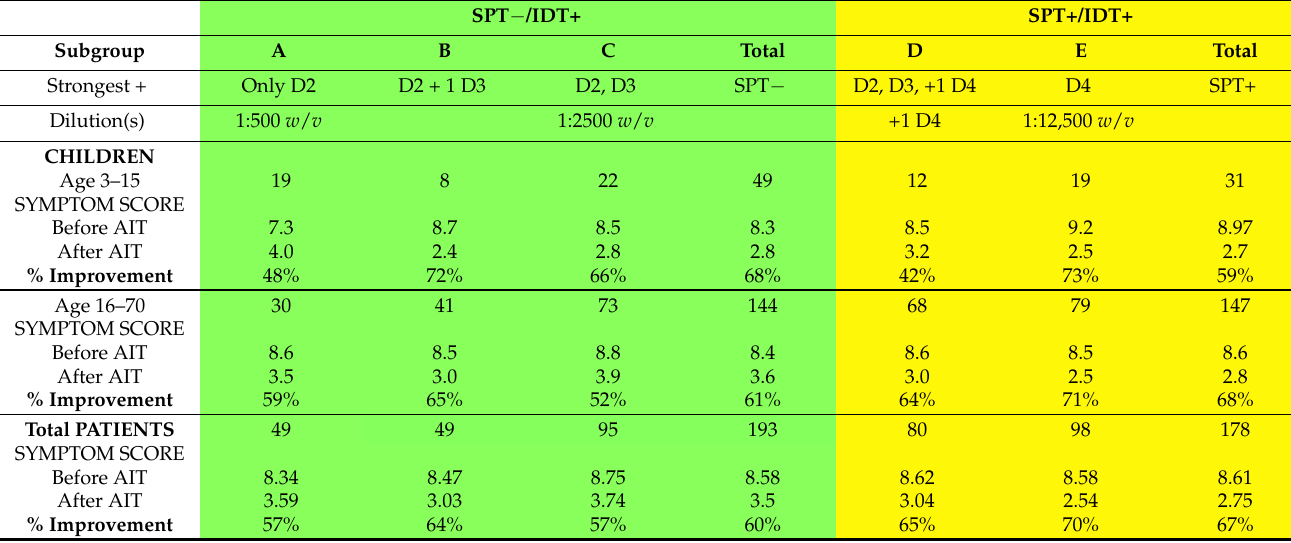
Table 1. Immunotherapy Improvement: symptom scores by degree of allergen reactivity end points, before treatment and after reaching AIT maintenance among 371